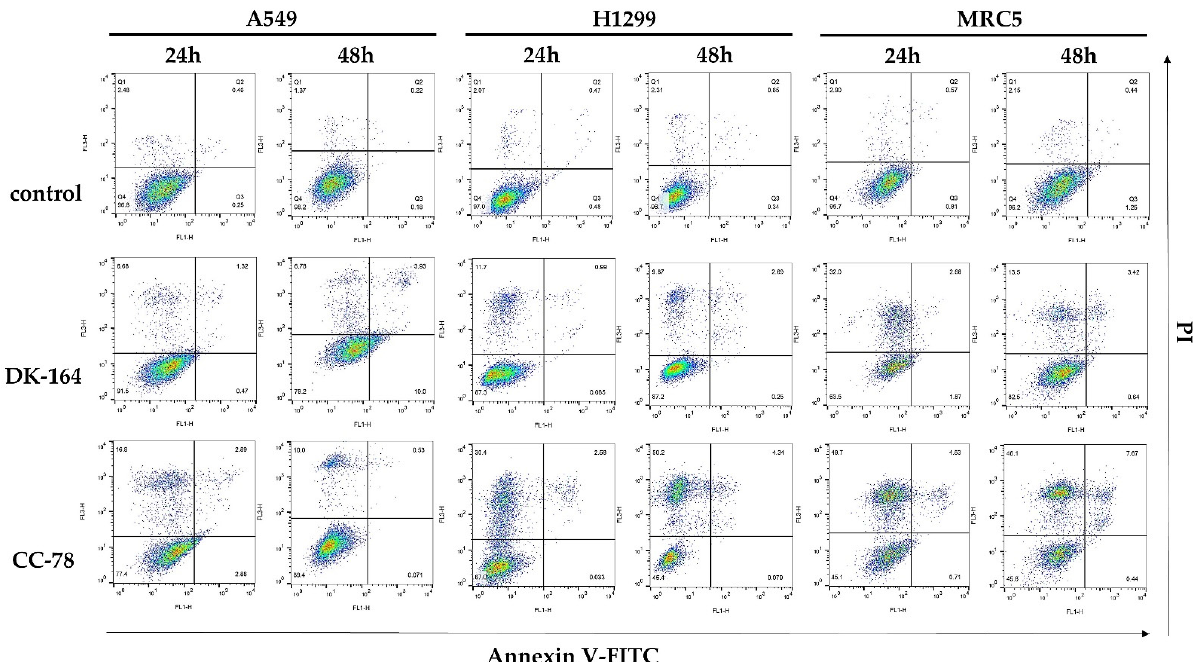
Figure 3. Apoptosis was assessed by staining with Annexin V ‐ FITC/ PI followed by flow cytometry. Representative statistics of this analysis are presented. A549, H1299, and MRC5 cells were treated for 24 h or 48 h with the calculated IC50 concentrations of the compounds DK ‐ 164 and CC ‐ 78 (see Table 1). FACS analyses showed that each substance caused apoptosis and necrosis in all three lung cell lines, but with different intensities and time dependencies. DK ‐ 164 showed predominantly pro ‐ apoptotic activity in NSCLC cells, which was registered at a later stage of treatment and mostly affected A549 cells with functional p53 proteins. After 48h treatment, the early apoptotic cells were increased approximately 55 times compared to the untreated controls. In H1299, treatment resulted in a five ‐ times increase in necrotic cells after 48 h. Non ‐ cancerous MRC5 cells responded to treatment as early as 24 h, with a five ‐ times increase in apoptosis. The number of viable cells remained stable, and the initial apoptotic cells showed signs of necrosis. All experiments demonstrated a significant reduction in viable cells after treatment with CC ‐ 78, and unlike with DK ‐ 164, the dominant mechanism of cell death was necrosis. Particularly affected were H1299 cells, in which necrotic cells increased 14.7 times at 24 h and even 22 times at 48 h of treatment. A considerable increase in the number of necrotic cells was also observed in MRC5, and the effect was registered at the 24th hour without intensifying with prolonged treatment. Rapid action of CC ‐ 78 within 24 h was also measured in A549 cells, in which the necrotic fraction increased 6.8 ‐ fold without potentiating the effect at 48 h. The results were plotted and are presented in Figure 4.